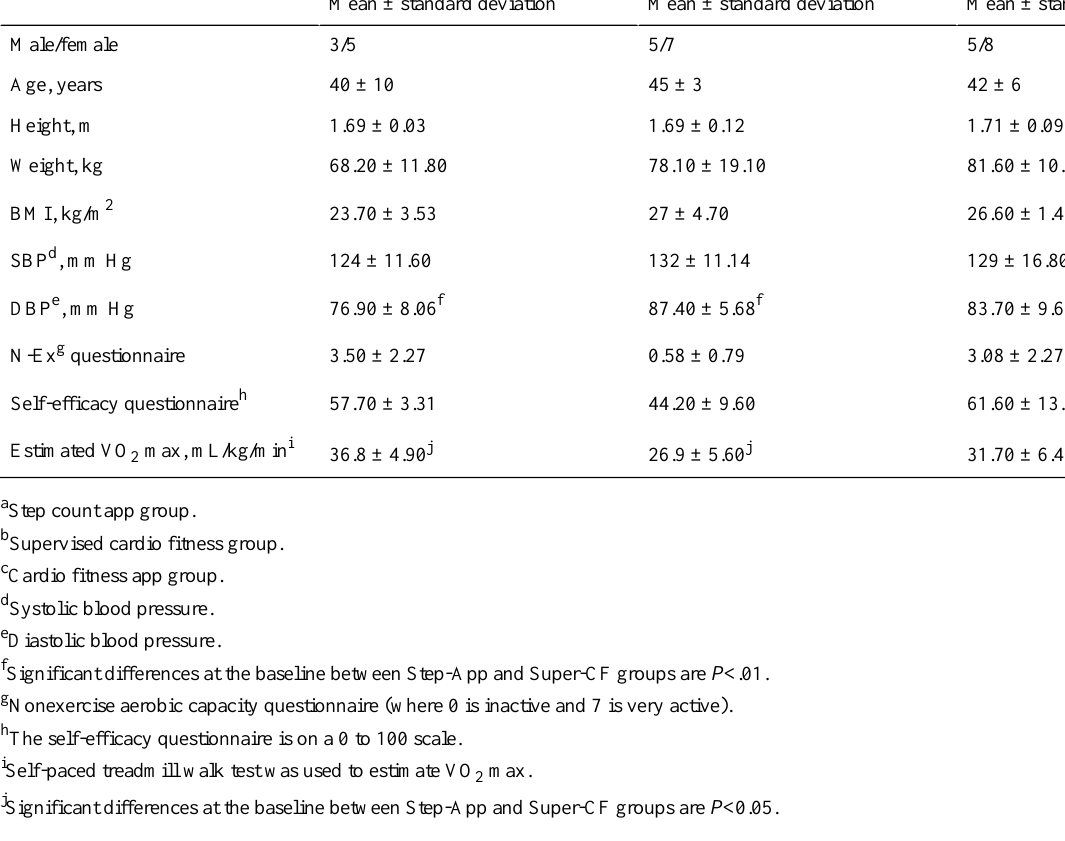
Table 1. After a baseline CRF evaluation, 10 participants were excluded from the study because having a treadmill test estimated VO max > 45 mL/kg/min (Figure 1). 2